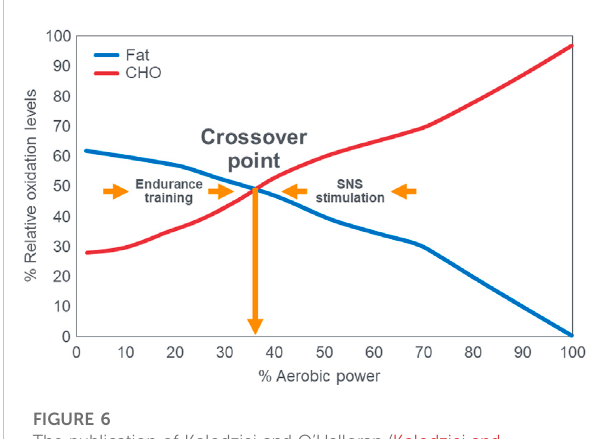
FIGURE 6 The publication of Kolodziej and O ’ Halloran (Kolodziej and O ’ Halloran, 2021) includes this fi gure which differs substantially from the more usual graph shown in Figure 1. Note that the rate of carbohydrate oxidation of ~30% – 40% at rest and during low- intensity exercise is substantially higher than values in Figure 1. Also, the crossover point occurs at less than 40%VO 2 max. Reproduced from (Kolodziej and O ’ Halloran,